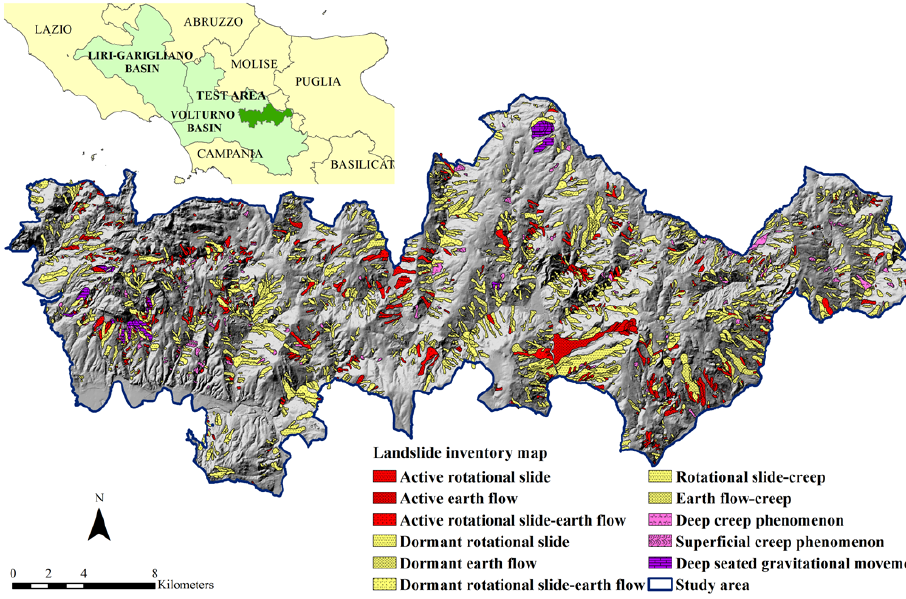
Fig. 2. Distribution and types of slow-moving landslides over the study area.